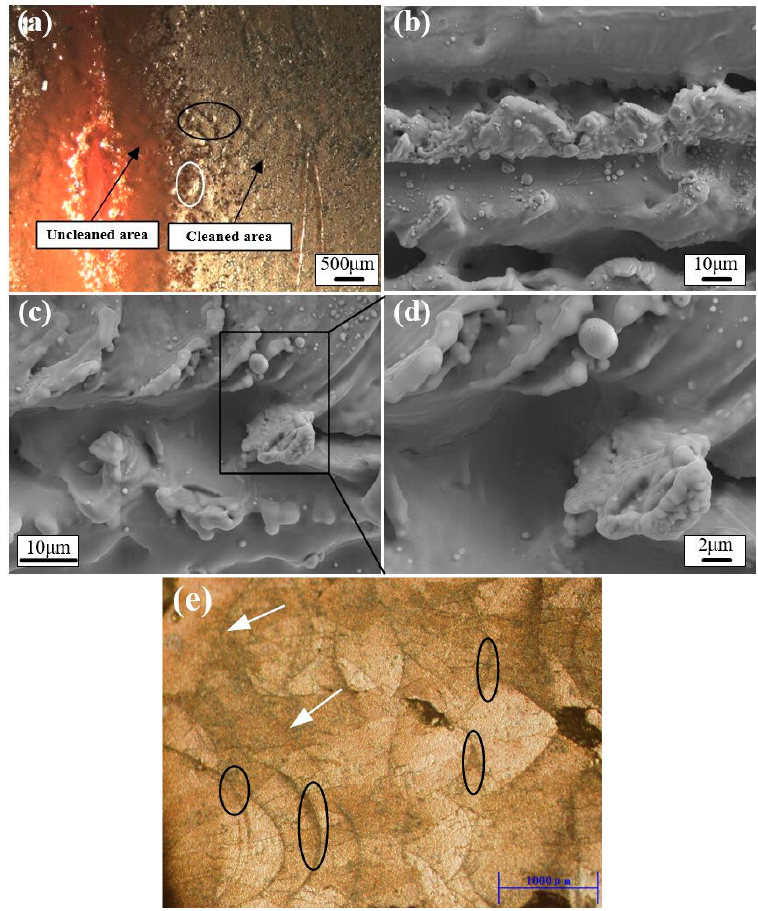
Figure 7. The photo-micrograph of the uncleaned and the laser cleaned area ( a ), ( b – d ) are the according magnification images, ( e ) is the micrograph of the laser remelted surface etching with 0.5% HF solution. White arrows indicate grain boundary β -phase.